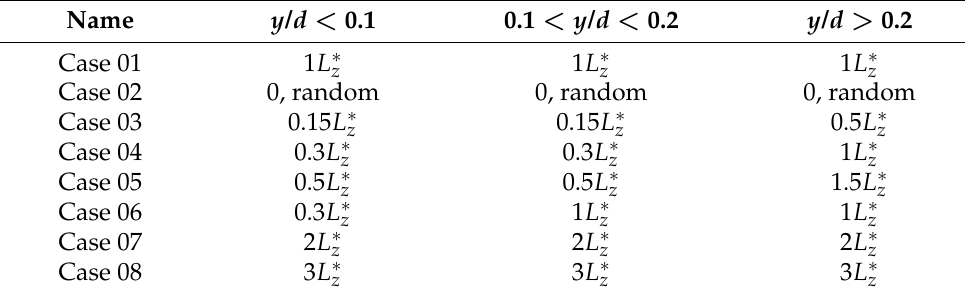
Table 1. Size of length scales applied in the